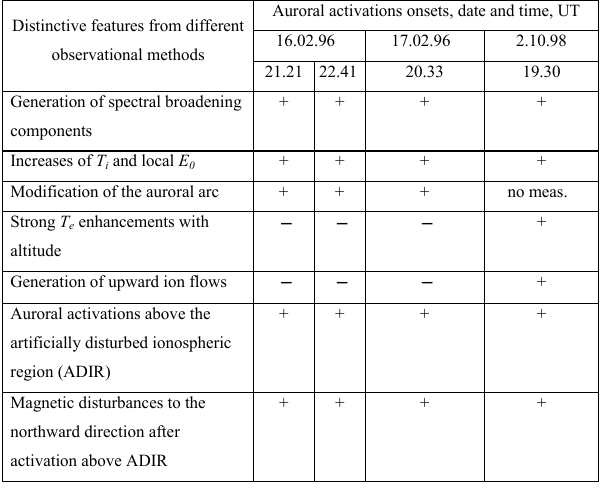
Table 4. Distinctive features related to auroral activations in course of the experiments.